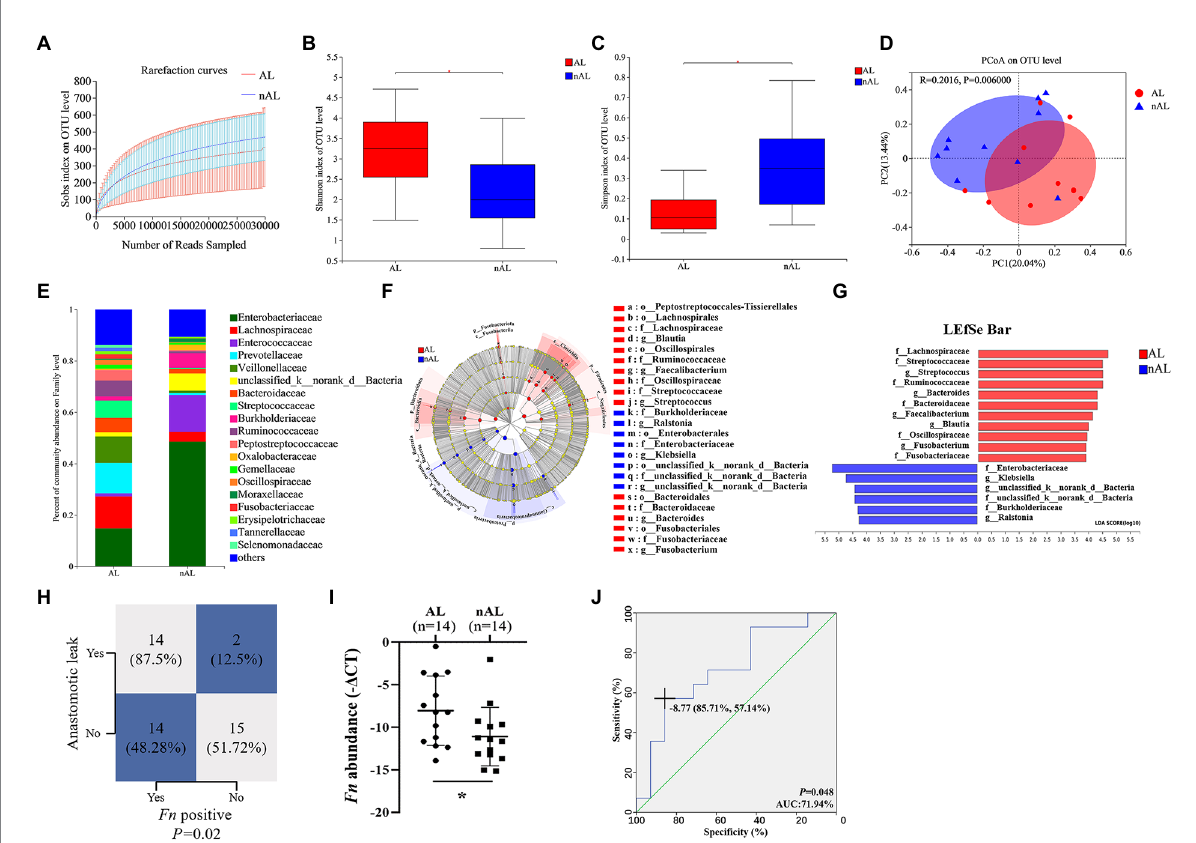
FIGURE 1 Fn is a risk factor for AL in CRC patients following surgery. (A) Rarefaction curves of species richness between the AL and nAL group. (B,C) Alpha diversity (Shannon index and Simpson index) between AL and nAL group. (D) The PCoA analyses based on BrayCurtis distance were used to reveal the β -diversity between AL and nAL group, ANOSIM statistical analysis. (E) The relative abundance of microbiota between AL and nAL group (family level). (F) A cladogram representation of data in CRC patients between AL and nAL group by 16S rDNA sequencing. (G) LDA coupled with the effect size measurements identifies the significant abundance of data in (F) . (H) Statistical analysis was conducted based on the positive of Fn and AL rate in Cohort 2, Chi-square test. (I) Statistical analysis of the amount of Fn in Cohort 2, nonparametric Mann–Whitney test. (J) ROC analysis was conducted based on the amount of Fn in CRC. * p <